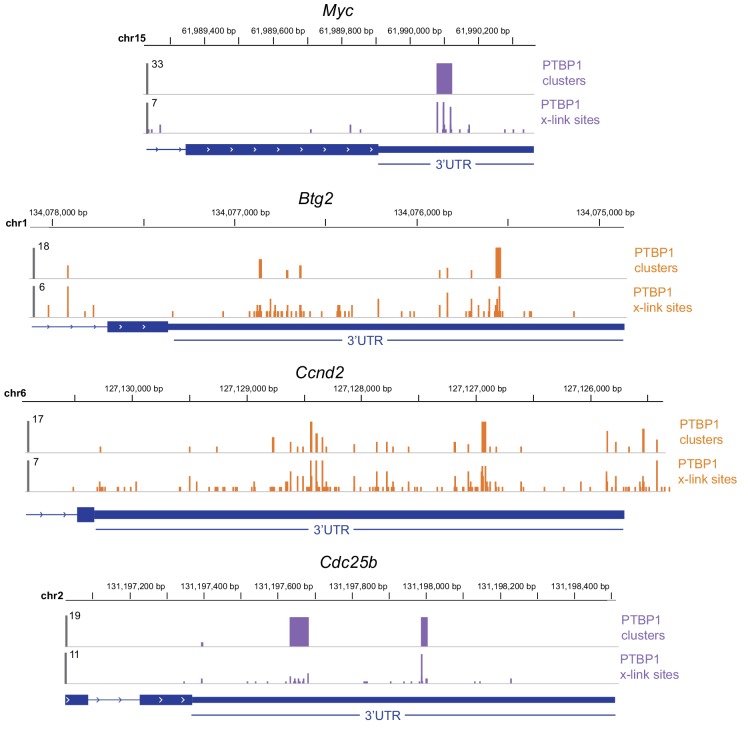
PTBP1 binding to target transcripts.PTBP1 binding (iCLIP data) to 3’UTRs.